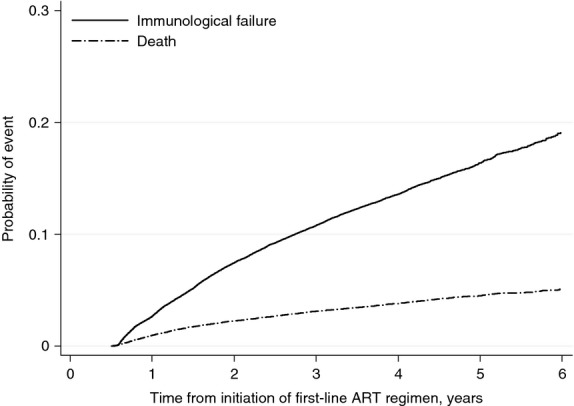
Probability of immunological treatment failure or death, following initiation of first-line ART. ART, antiretroviral therapy. Y-axis truncated at 0.3. Persons with <6 months of follow-up (including due to death) were excluded from the analyses. Immunological failure was not defined until at least 6 months after treatment initiation.